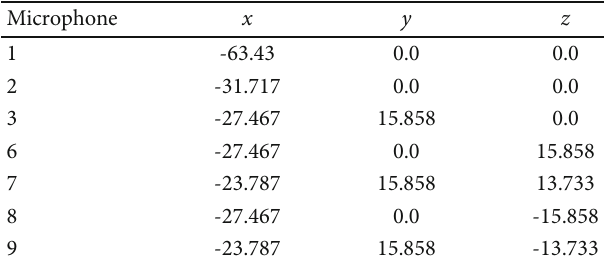
Table 1: Coordinates of microphone locations (normalized by the rotor chord length) [20, 21, 33].